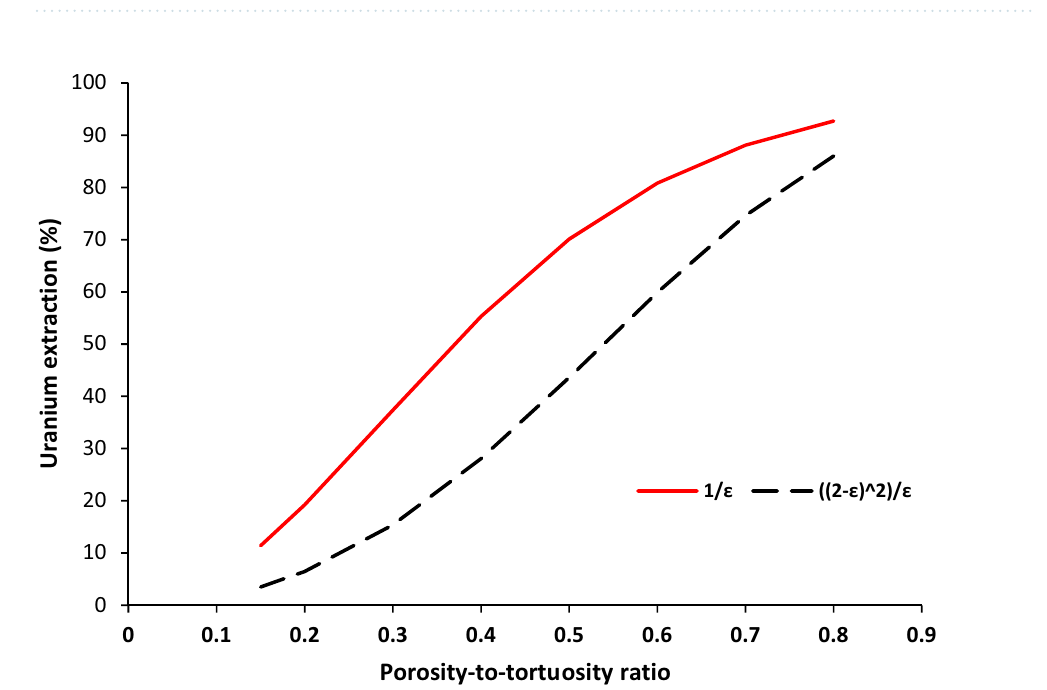
Figure 10. Uranium extraction as a function of porosity-to-tortuosity